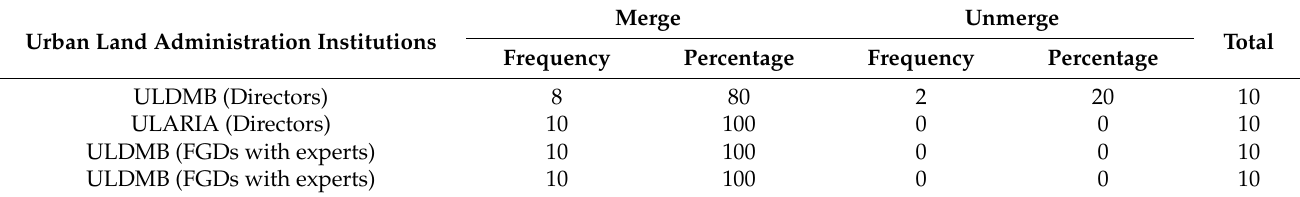
Table 3. Interview and FGD results from ULDMB and ULARIA